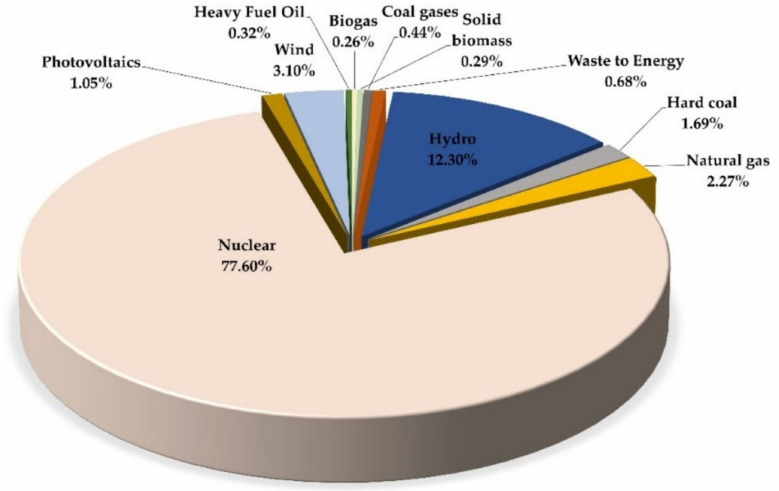
Figure 3. Electricity mix for France (2021). (Source: GaBi 8.0 database).